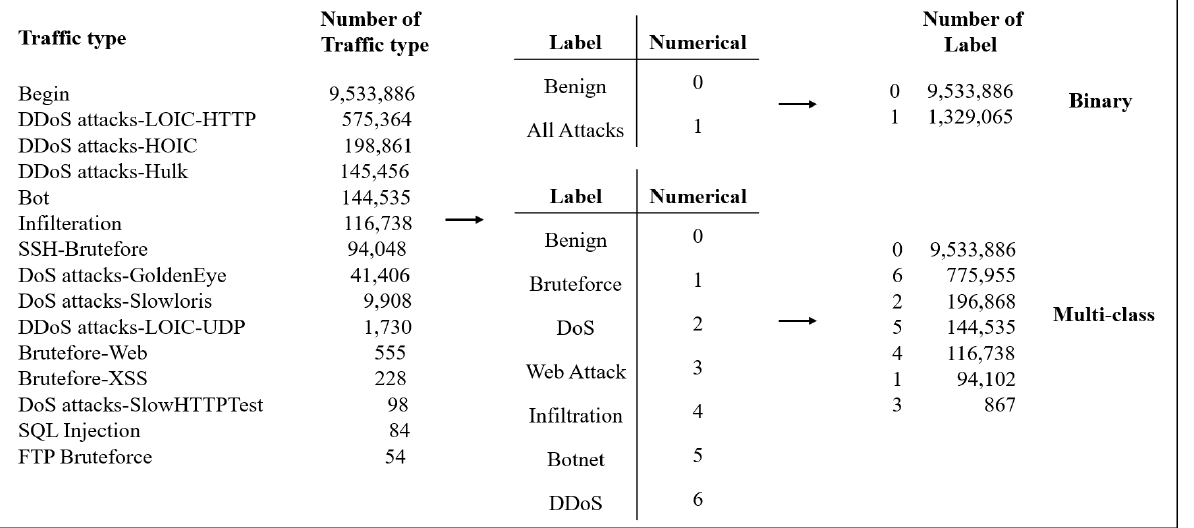
Figure 2. Benign and offensive labels, digital representation, and binary and multi-class classification.